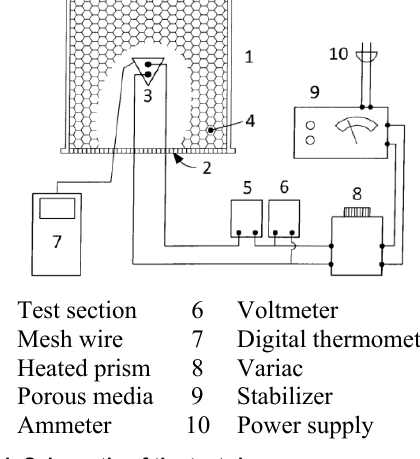
Figure 1. Schematic of the test rig